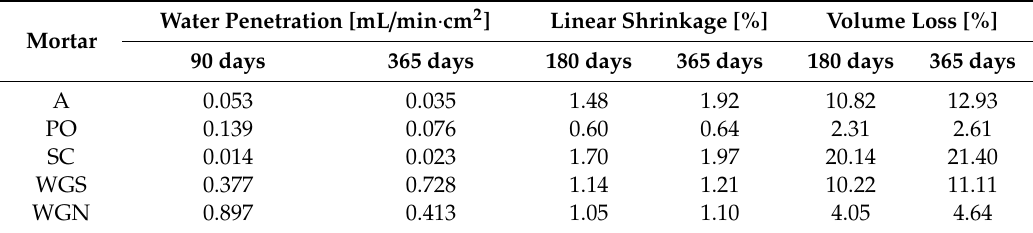
Table 3. Water penetration and shrinkage of the mortars.